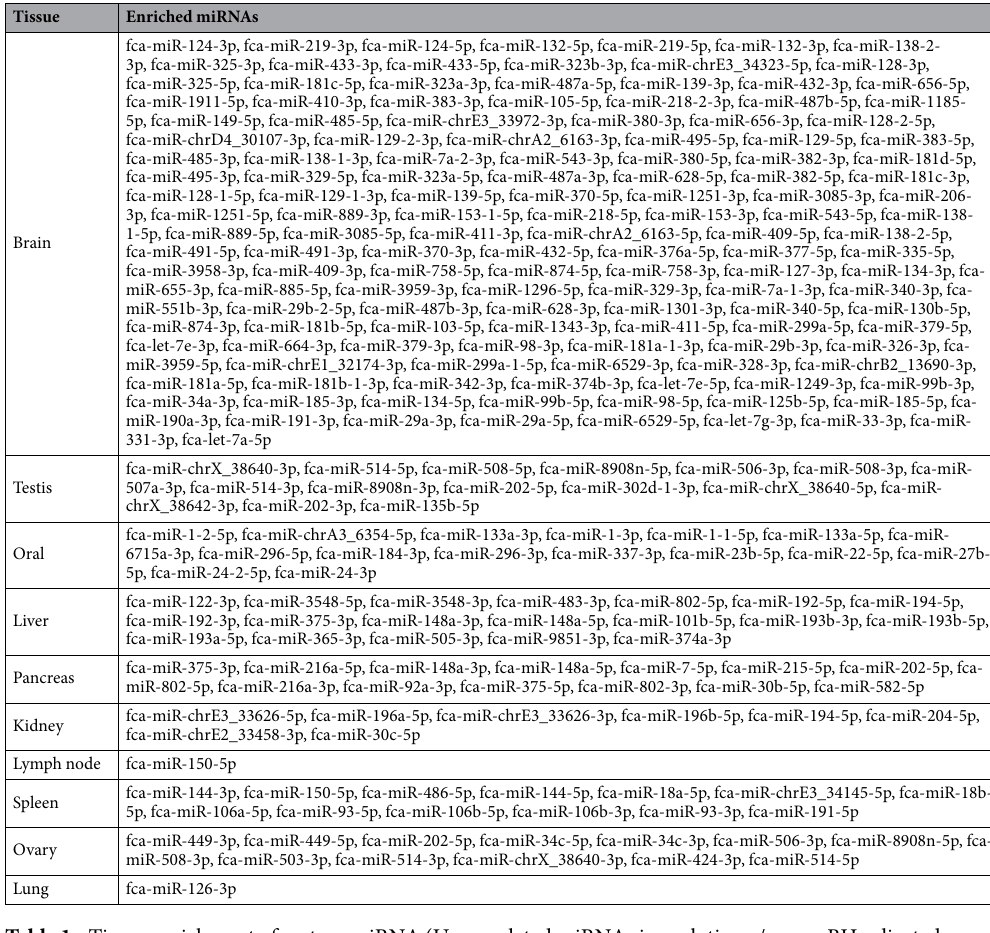
Table 1. Tissue enrichment of mature miRNA (Up-regulated miRNAs in each tissue/organ, BH-adjusted Pvalue <